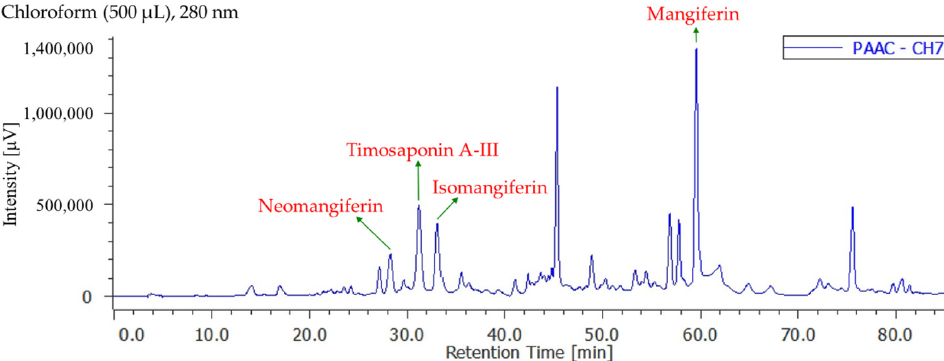
Figure 3. Reverse-phase HPLC chromatogram of chloroform extract in salt-fried rhizomes of A. asphodeloides . Table 5. Identification and quantification of the main active compounds of A. asphodeloides in different solvent extracts.